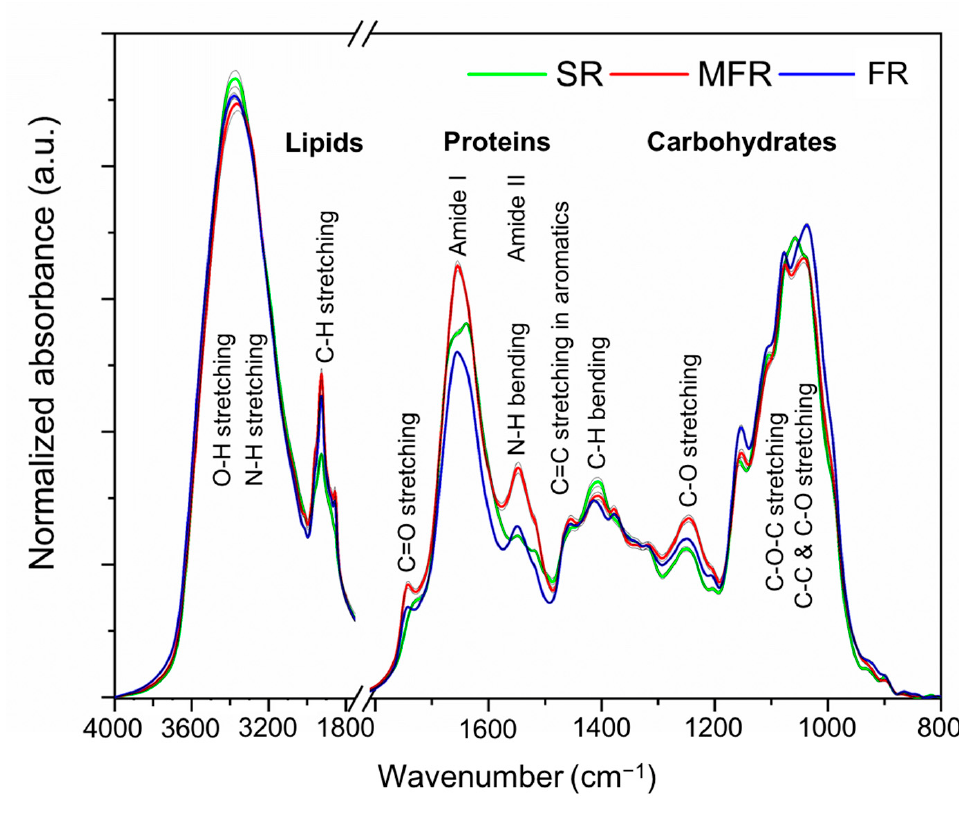
Figure 3. The vector normalized and average FTIR spectra of the root samples collected from germinating seeds (two-day-old) surrounded by S. mycoparasitica against F. graminearum (MFR, red line); the seed infected by F. graminearum (FR, blue line); the non-treated or non-infected seed (SR, green line). Data are means of vector normalized 6 spectra for each treatment and standard errors are shown as black